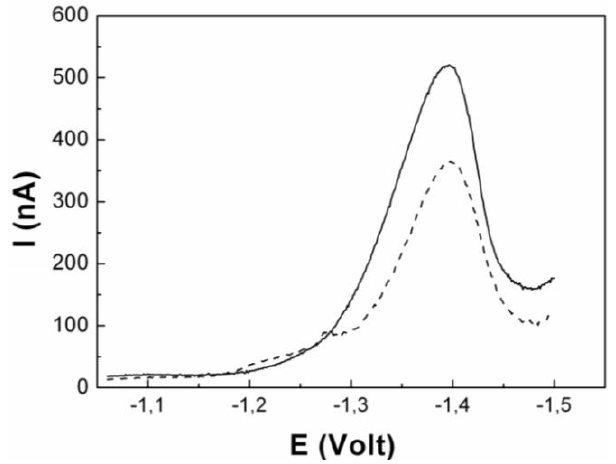
FIGURE 1. Stripping voltammogram of 20 μ Μ imidacloprid in lymphocyte culture media, for two different incubation concentrations — (solid line) 5 μ Μ and (dotted line) 20 μ Μ of ΚΝΟ 3 . Experimental conditions: pH = 7.4, T = 2 o C, E acc = –1060 mV, t acc = 80 sec in 10 m M Britton-Robinson buffer.